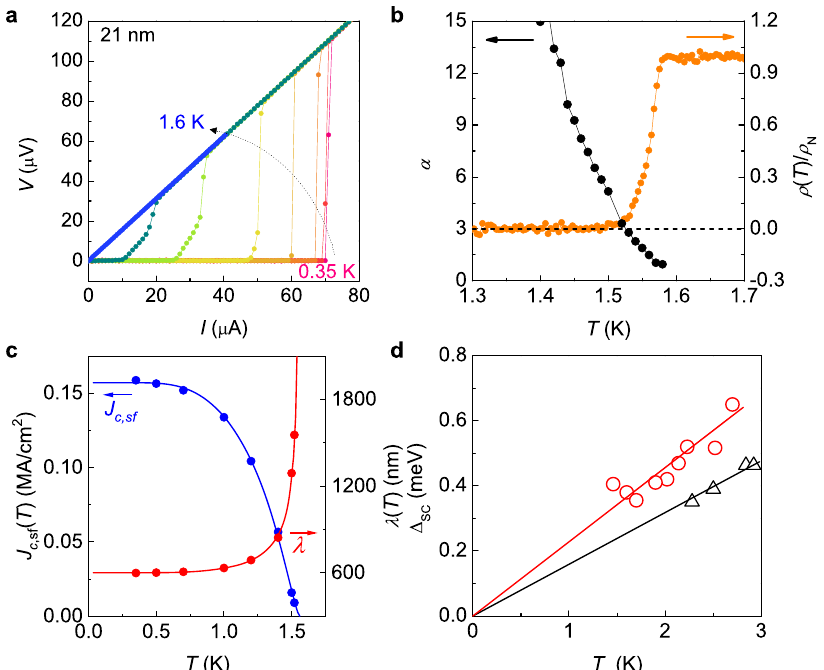
Fig. 4 Strong superconducting coupling in IrTe 2 nano fl akes. a Current-voltage ( IV ) characteristics at various temperatures for a representative IrTe 2 nano fl ake with d = 21 nm. b Temperature dependence of the normalised resistivity and the exponent α for a 21-nm-thick IrTe 2 nano fl ake. Exponent α is determined from the power-law behaviour V ∝ I α in the IV curves, as expected by BKT transition. c Critical current density (blue) and the penetration depth (red) as a function of temperature for a 21-nm-thick IrTe 2 nano fl ake. Solid lines are the fi ts to the self-critical-current model described in the